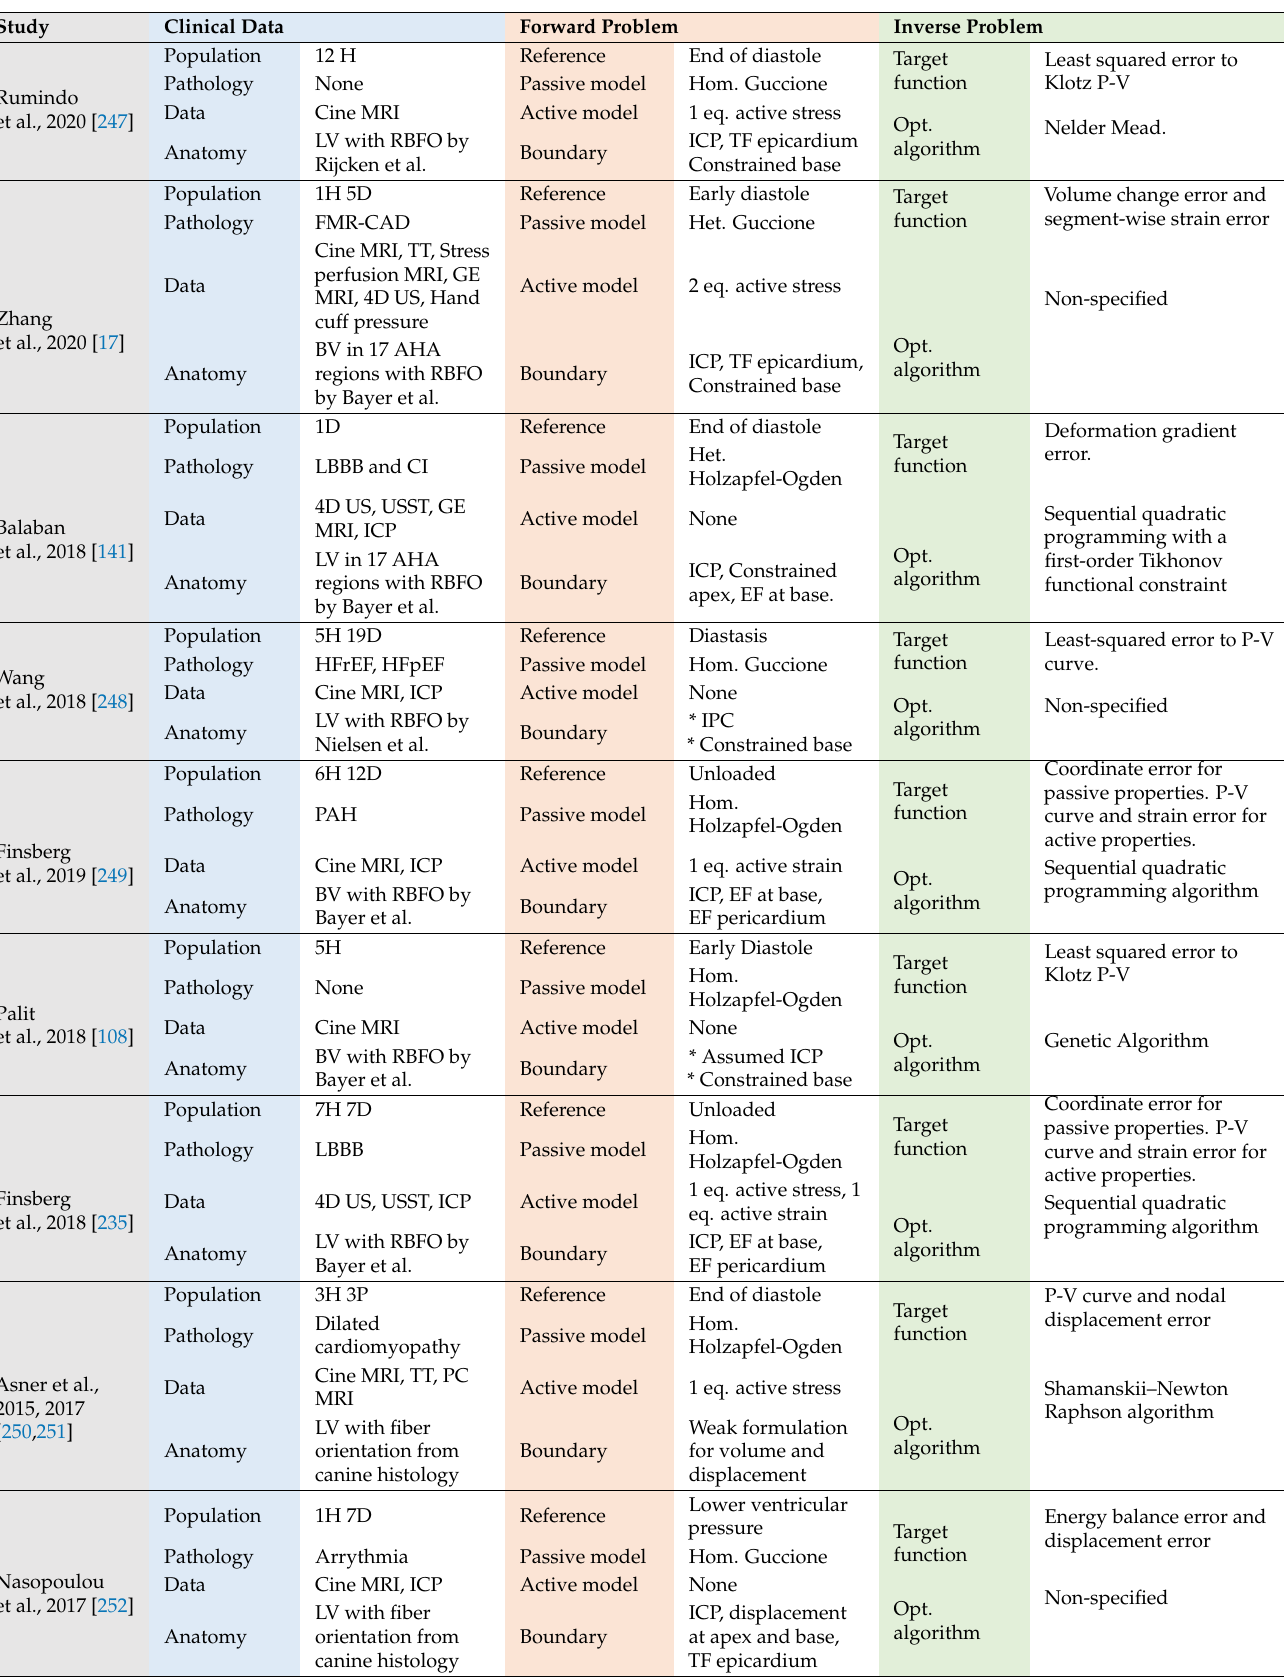
Table 7. Literature review of iterative inverse models for the analysis of human heart tissue